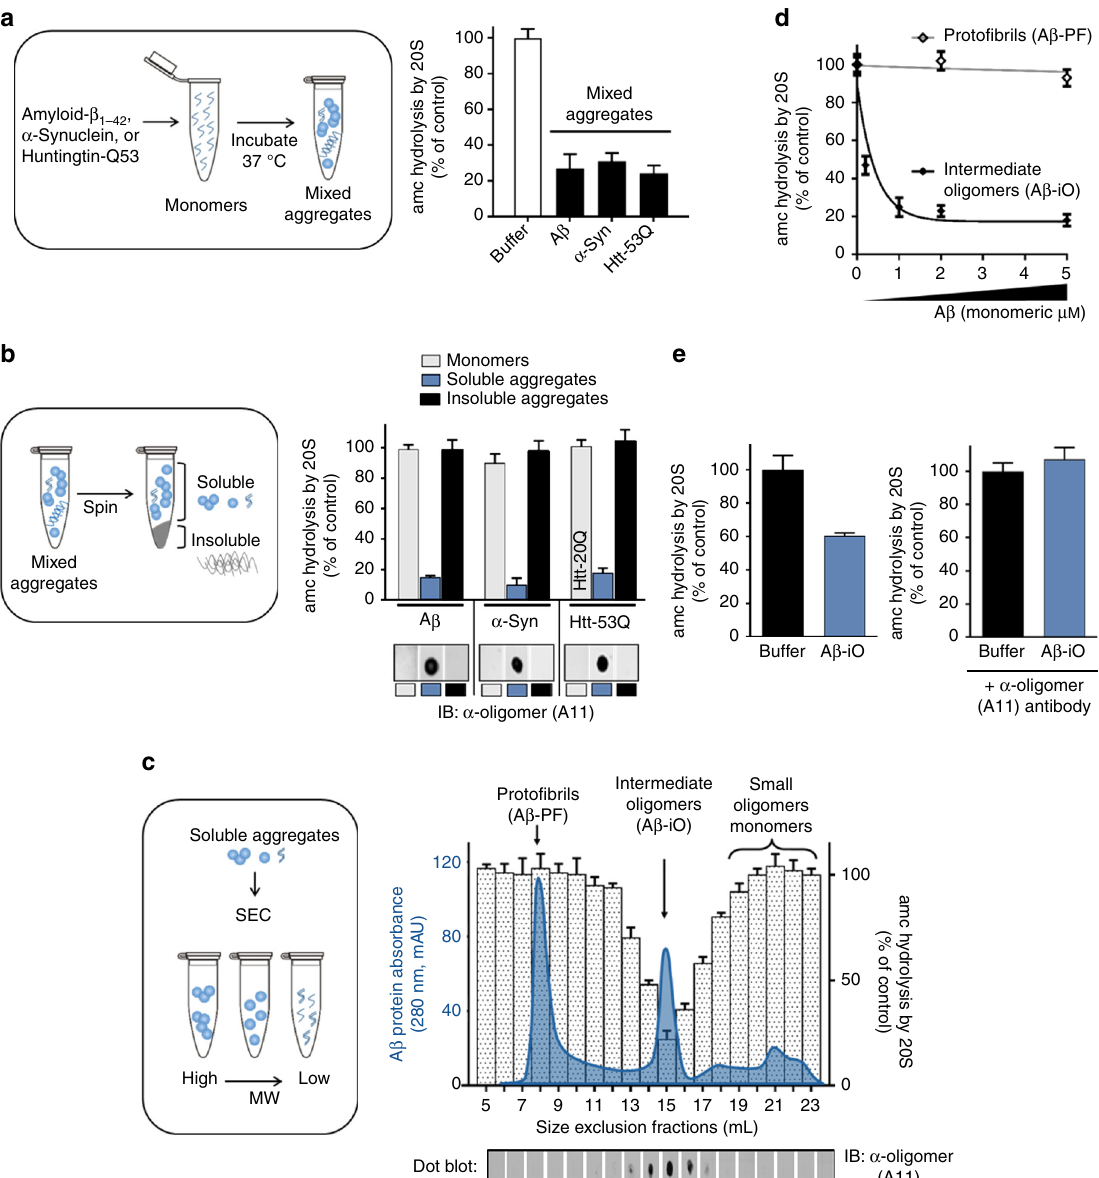
Fig. 1 A speci fi c conformation of soluble oligomers potently inhibits the mammalian 20S proteasome. a Mammalian 20S proteasomes were incubated with mixed aggregates of A β 1 – 42 (5 μ M), α -Syn (1 μ M), Htt-53Q (0.1 μ M), or an equal volume of oligomer buffer (control). Proteasome activity (linear rate of LLVY-amc hydrolysis) is represented as a percentage of activity compared to the control. b Crude aggregates from a were separated into soluble and insoluble aggregates (schematic, left) and were assayed as in a (bar graph, right). For huntingtin monomers, Htt-20Q monomers were used because pure Htt-53Q monomers could not be obtained due to rapid oligomerization. Dot blots of monomers, soluble aggregates, and insoluble aggregates from b were probed with the conformation-dependent anti-oligomer “ A11 ” antibody (bottom right). c Soluble A β aggregates from b were separated by size exclusion chromatography (Abs 280nm , solid blue line). Two microliters from each fraction was evaluated for its effect on 20S proteasome chymotrypsin-like activity (bars) and probed for anti-oligomer A11 reactivity (dot blot, bottom). d Proteasome activity with up to 5 μ M of A β oligomers (A β -iO) or A β proto fi brils (A β - PF) from c . e Intermediate oligomers from d were pre-incubated with anti-oligomer A11 antibody (A β -iO + A11) or an equal volume of antibody buffer (A β - iO) for 30 min at 37 °C before to addition to proteasome activity assay. Final concentration of A β -iO in the assay was 0.25 μ M (the ~IC 50 as determined in d ). The concentrations of aggregates are calculated based on the respective monomeric peptide/protein mass (A β , 4.5 kDa; α -Syn, 14 kDa; and Htt-53Q, 22 kDa). All controls contained an equal volume of buffer identical to that of the respective aggregates. The data are representative of three or more independent experiments performed in triplicate. Error bars represent ± standard